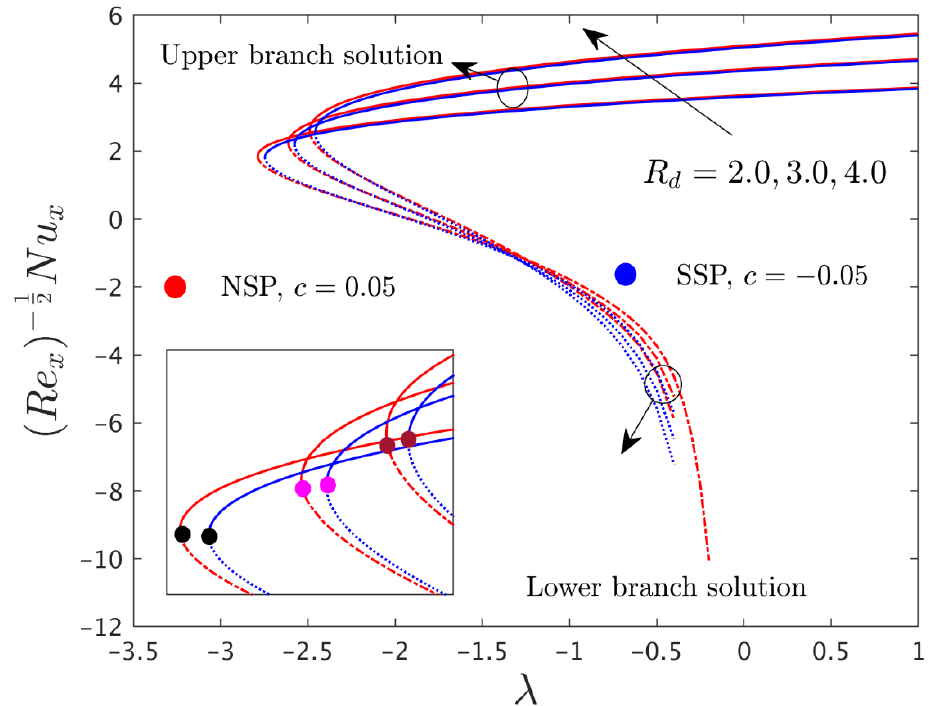
Figure 9. Heat transfer rate Re x − 1/2 Nu x for varying R d